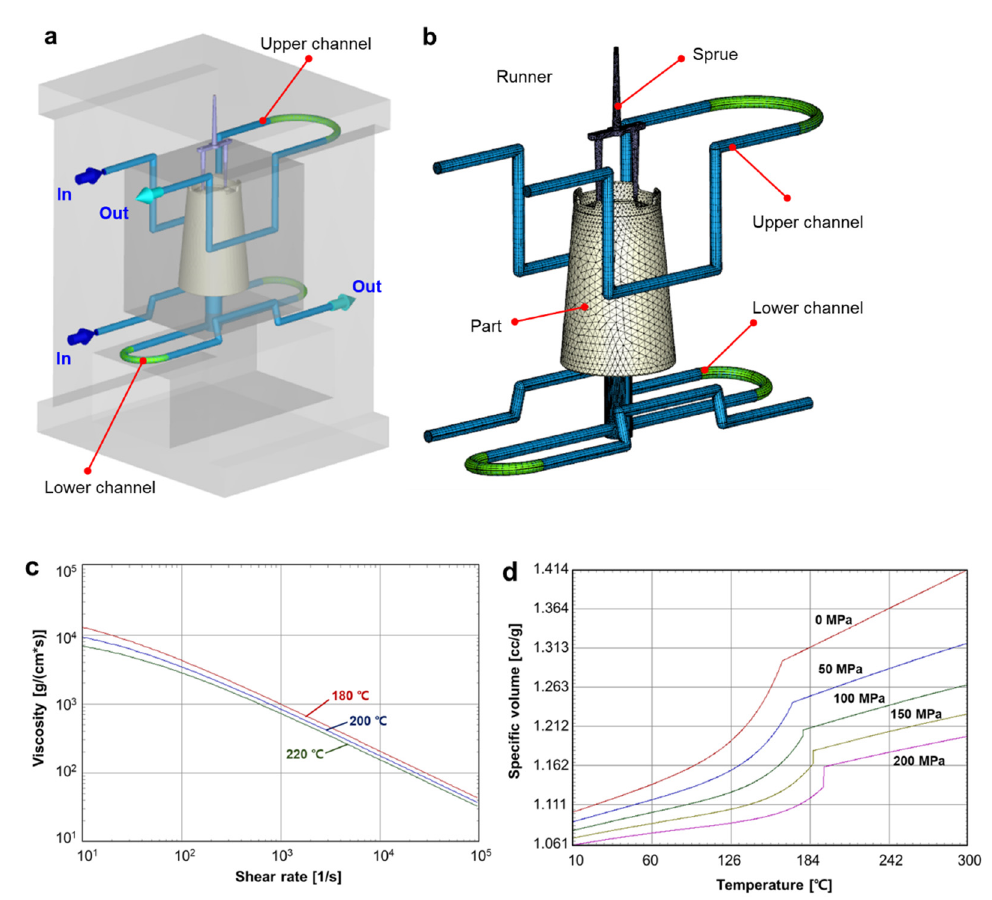
Figure 3. Description of the injection molding simulation conditions: ( a ) Configuration of the simu- lation model. ( b ) Finite element mesh. ( c ) Viscosity chart of the PP resin. ( d ) PvT diagram of the PP resin (H1500, LG Chemical). Table 3. Injection molding conditions for numerical simulation.